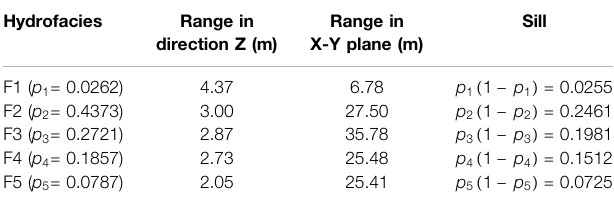
TABLE 3 | Ranges of an exponential variogram model fi tted to the experimental variogram by weighted least squares taking into account the experimental proportions. Hydrofacies Range in direction Z